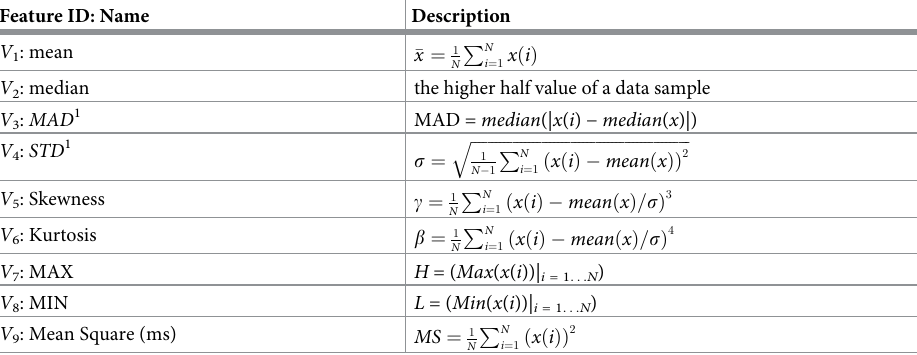
Table 1. Statistical measures and features [16].